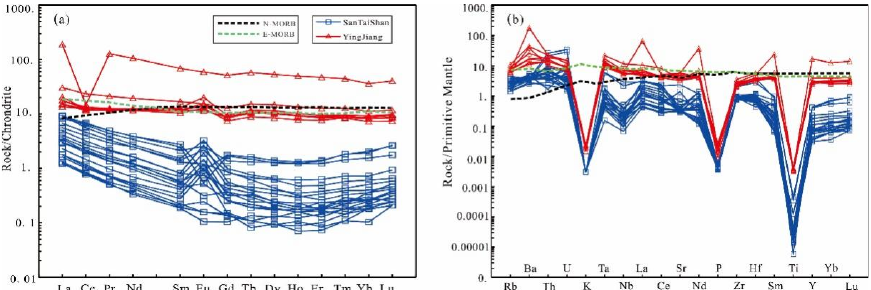
Figure 7. ( a ) Chondrite-normalized rare earth elements pattern. ( b ) Primitive mantle normalized trace elements pattern. Normalization and OIB values followed [30].